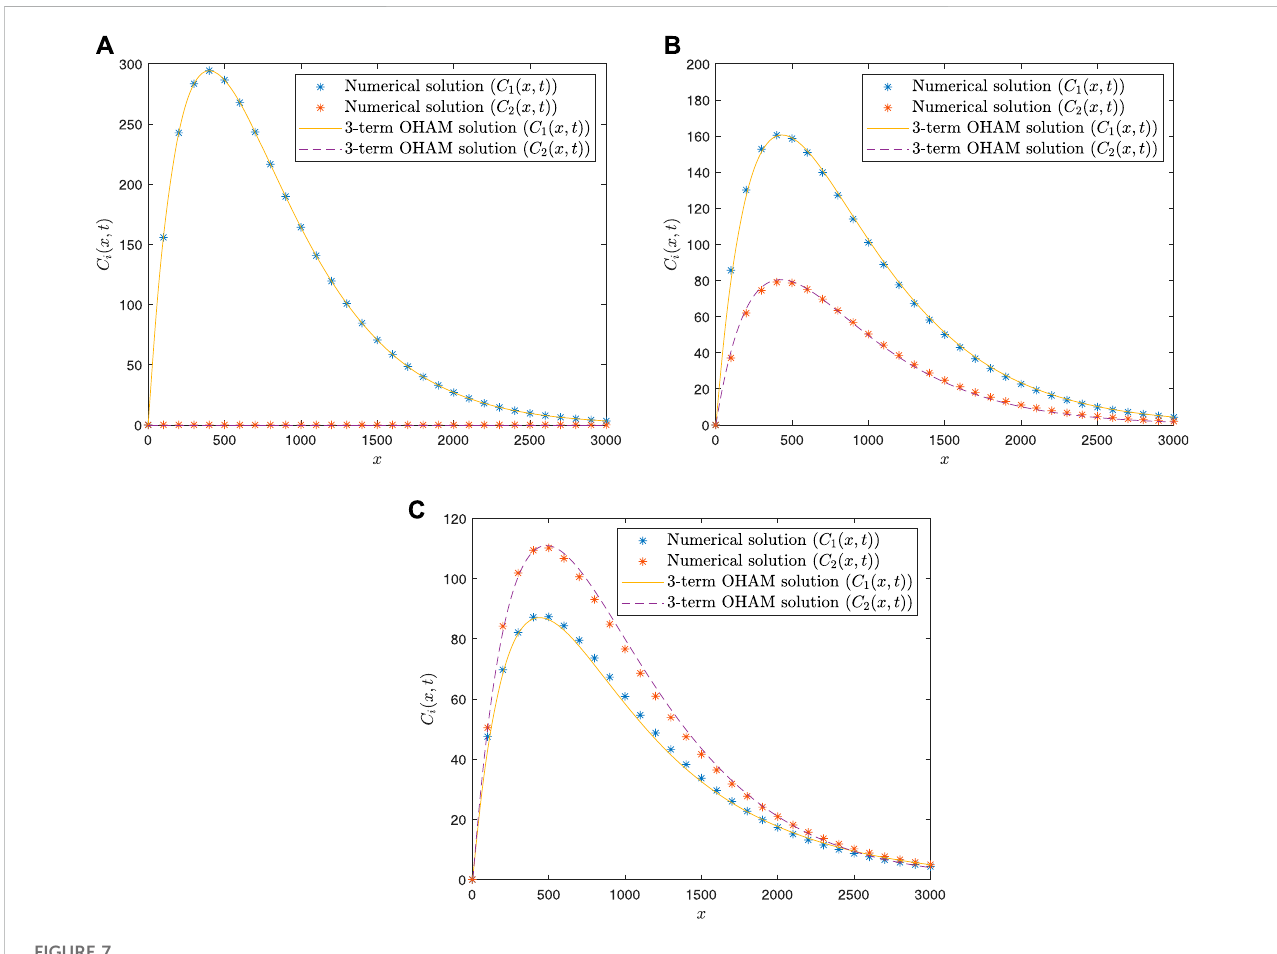
OHAM-based pollutant concentrations versus distance for both species at: (A) t (cid:2) 0 h, (B) t (cid:2) 20 h, and (C) t (cid:2) 40